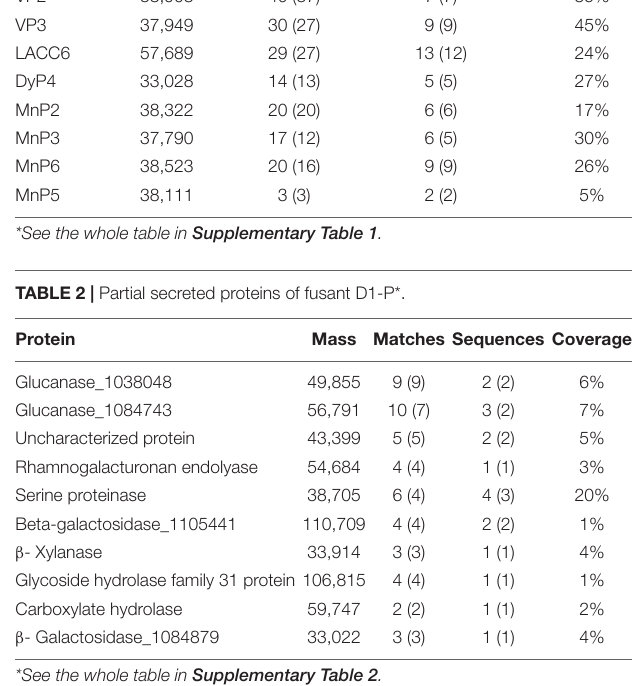
H1-G, H1-I, H1-M, and H1-O show a higher growth rate than WT on PDA